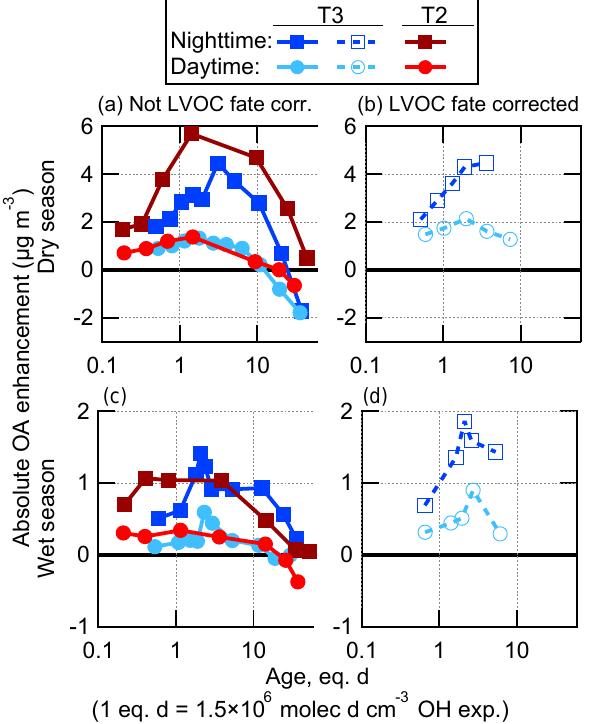
Figure 5. Absolute OA enhancement after OH oxidation in the OFR as a function of photochemical age, shown as binned averages for the wet (c, d) and dry (a, b) seasons at both the T2 and T3 measure- ment sites, and split into daytime (06:00–18:00LT) and nighttime (18:00–06:00LT) data. These data are shown both not corrected (left) and corrected (right) for LVOC fate. Note that the scale of the y axis is different between the wet and dry season panels. The aver- age ambient OA concentrations during the measurement times used here were 1.2 and 6.9µgm − 3 at T2 in the wet and dry seasons, and 1.3 and 9.5µgm − 3 at T3 in the wet and dry seasons, respectively.